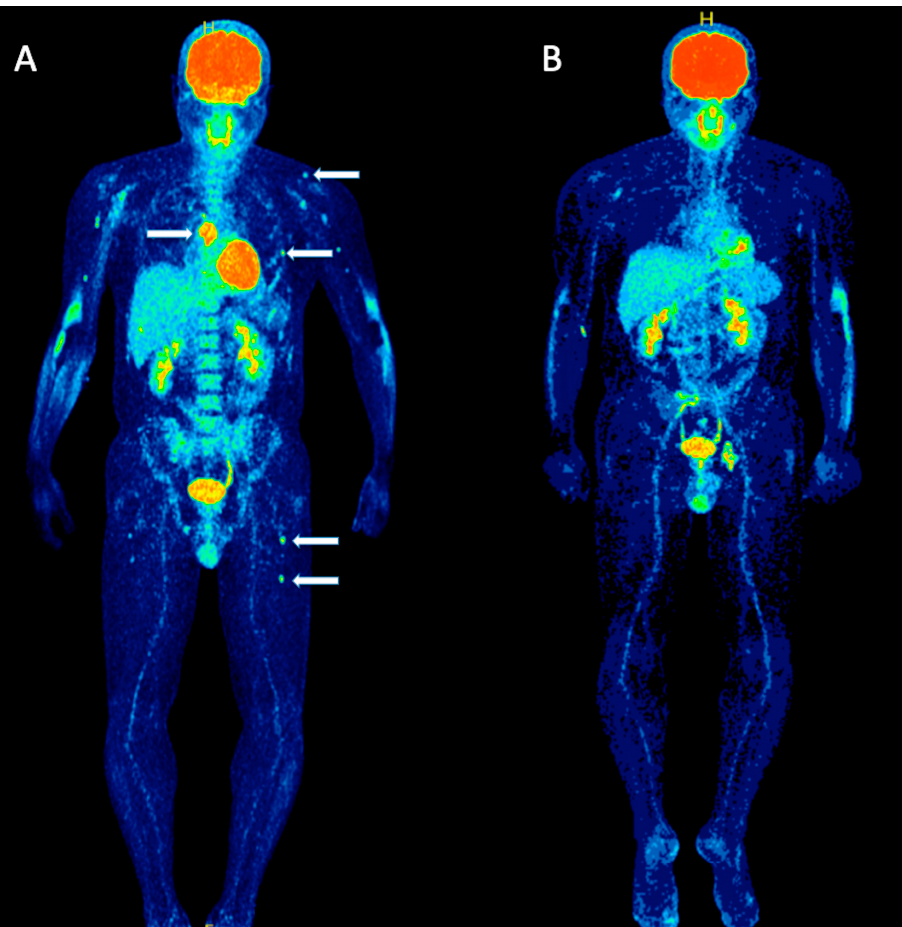
Figure 2. A 39-years old symptomatic MM patient scheduled for HDT and ASCT, undergoing 18 F-FDG PET/CT before and after therapy. Maximum intensity projection (MIP) 18 F-FDG PET/CT before therapy ( A ) revealed a mixed pattern of 18 F-FDG uptake with intense, diffuse uptake in the axial skeleton and multiple, focal bone marrow lesions for example in the sternum, ribs, humerus, scapula and femur (arrows). Follow-up 18 F-FDG PET/CT MIP after high-dose chemotherapy and ASCT ( B ) demonstrated a complete remission of both diffuse bone marrow uptake as well as focal MM lesions.